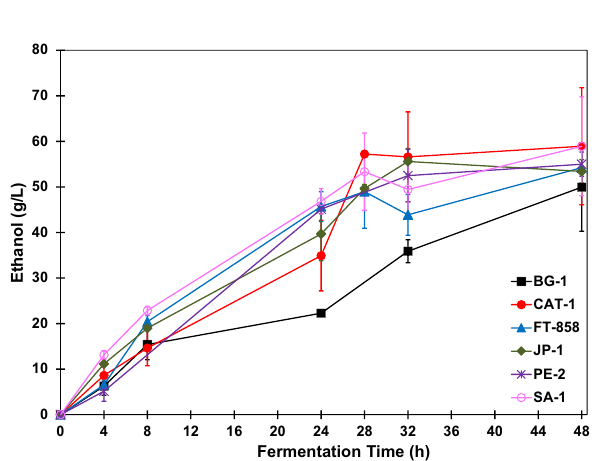
Figure 4. Ethanol concentration profiles during BRS PAMPA rice fermentations with S. cerevisiae strains. The error bar represents the standard deviation from the essays carried out in